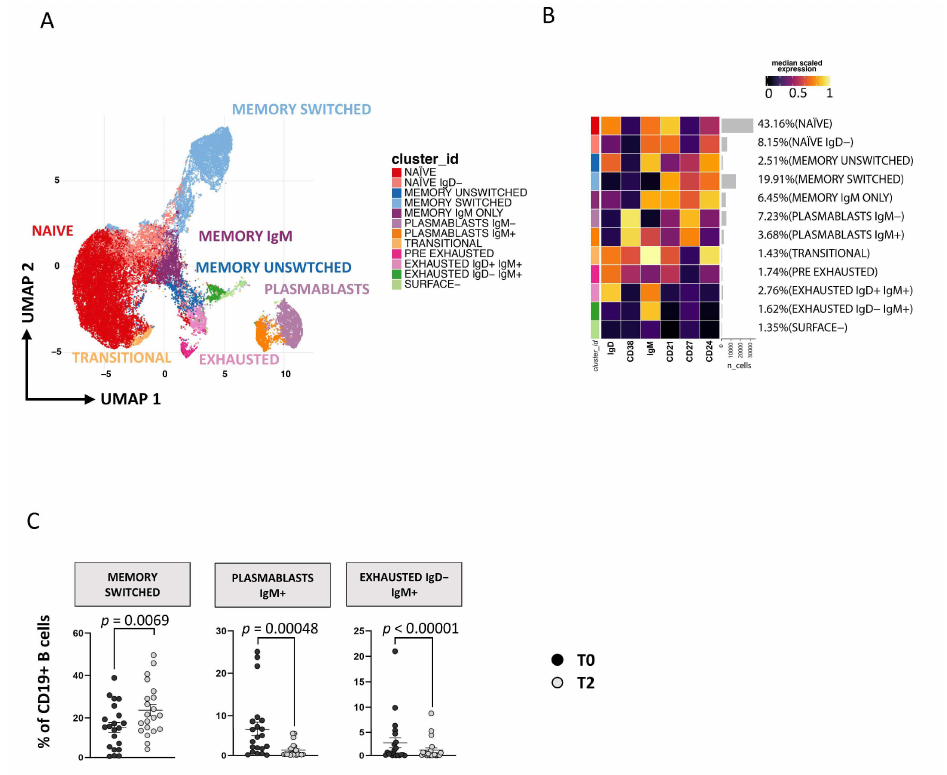
Figure 4. Time-dependent changes in CD19+ B-cell subsets. ( A ) Two-dimensional visualization of the CD19+ B-cell landscape by UMAP. ( B ) Heatmap shows a median-scaled expression of markers across the clusters. Bar plot along the rows and values in brackets on the right indicate the relative sizes of clusters. Twelve clusters were identified by FlowSOM using IgD, CD38, IgM, CD21, CD27 and CD24 markers. ( C ) Dot plots show the relative cells percentage of the 12 clusters from T0 (black circles; n = 21) and T2 (light-grey circles; n = 21) conditions. The central bar represents the mean ± SEM. The statistical relevant adjusted p -values obtained by patient pairing GLMM statistical test comparing T0 and T2 cluster percentages are reported in the figure (threshold: FDR ≤